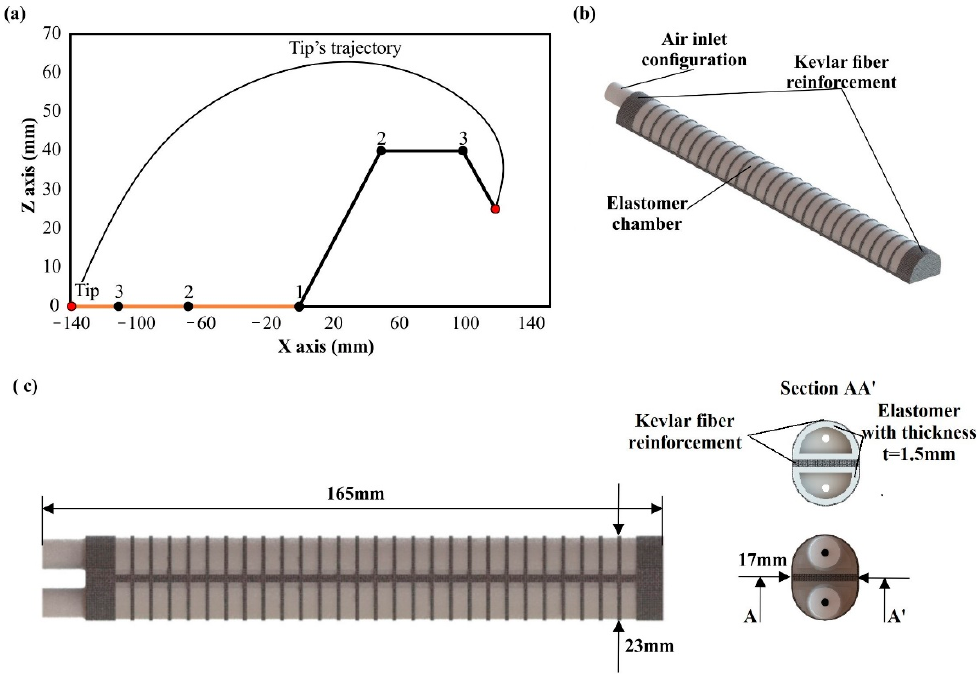
Figure 2. ( a ) Indicative 2D diagram of a human finger motion; ( b ) Half-tubular construction of soft actuator; ( c ) 3D models of the overall soft actuator with dimensions.